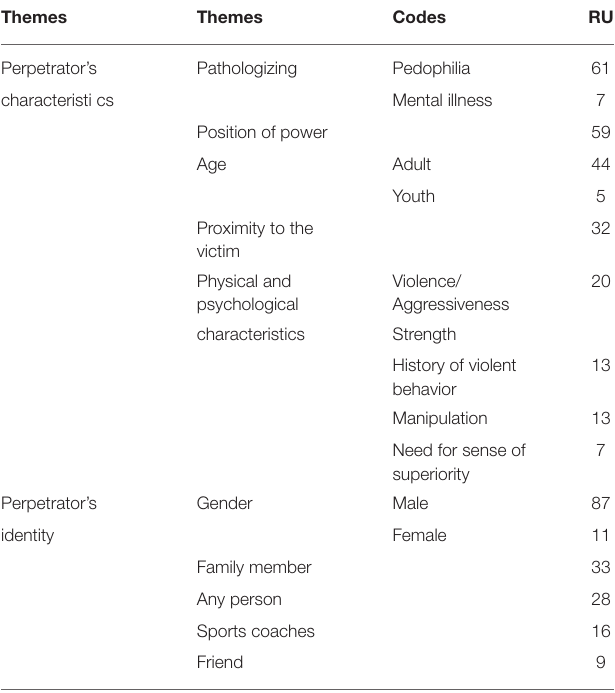
TABLE 5 | “Perpetrators and their characteristics” dimension’s themes, sub-themes and codes.